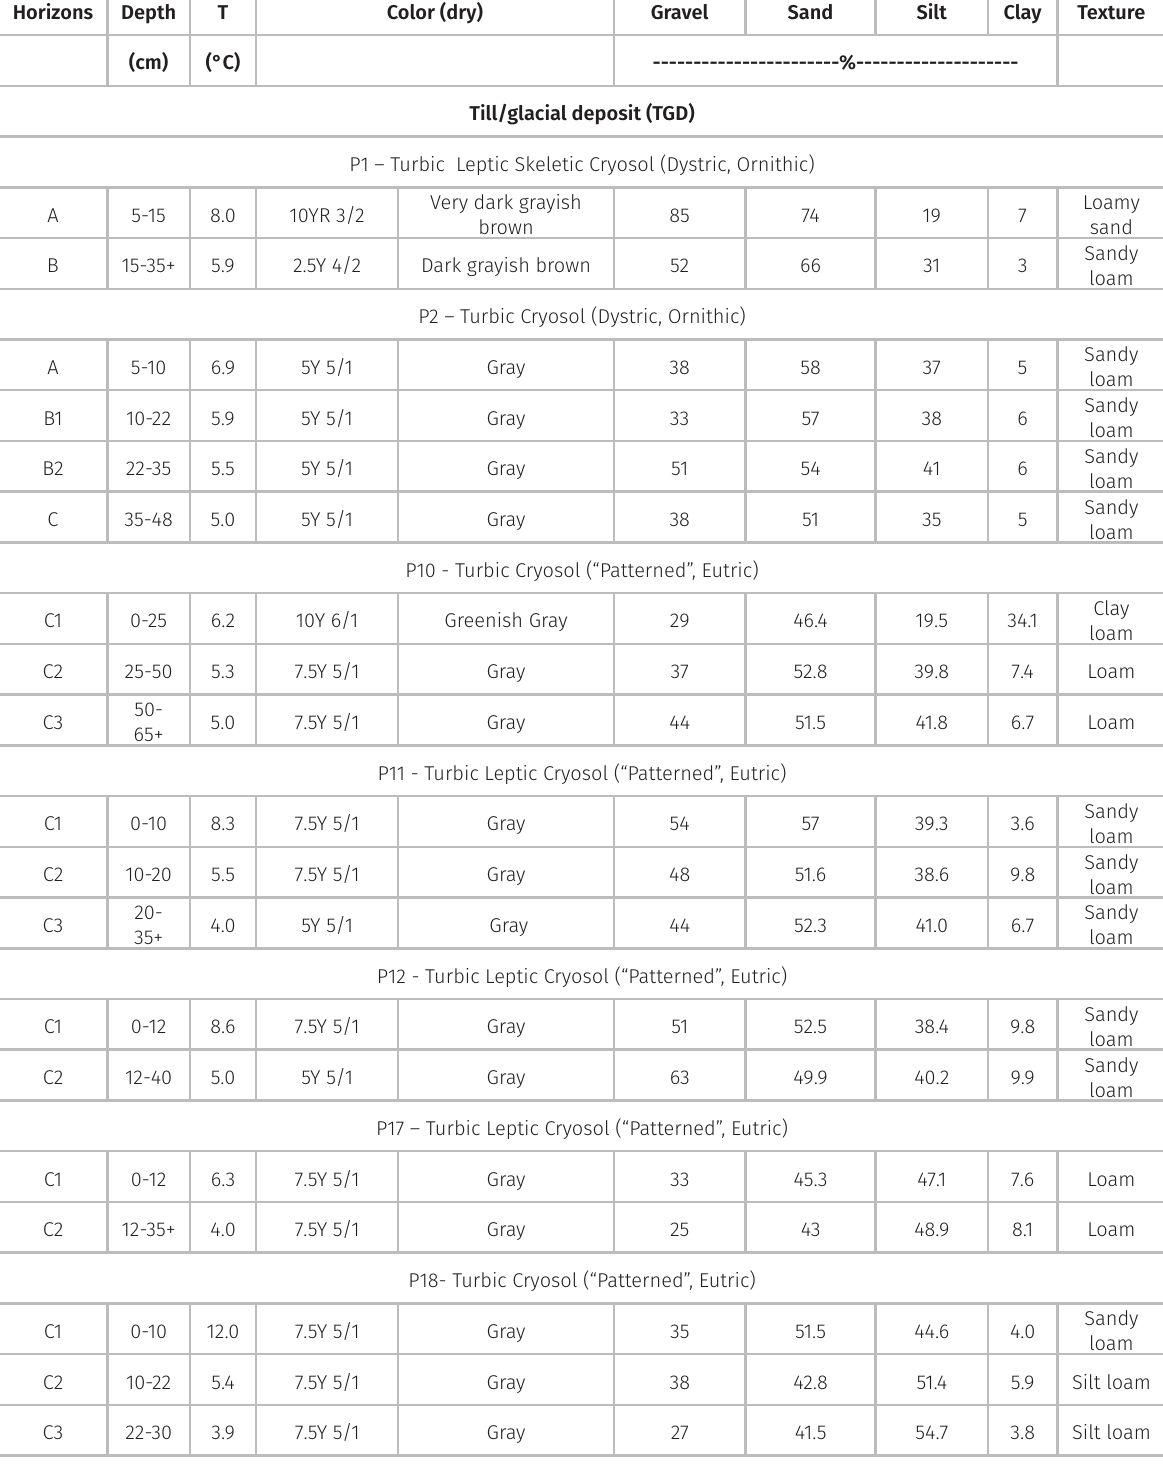
Table II. Temperature (T), color, physical properties and texture of the 20 soil profiles sampled in Stinker Point.